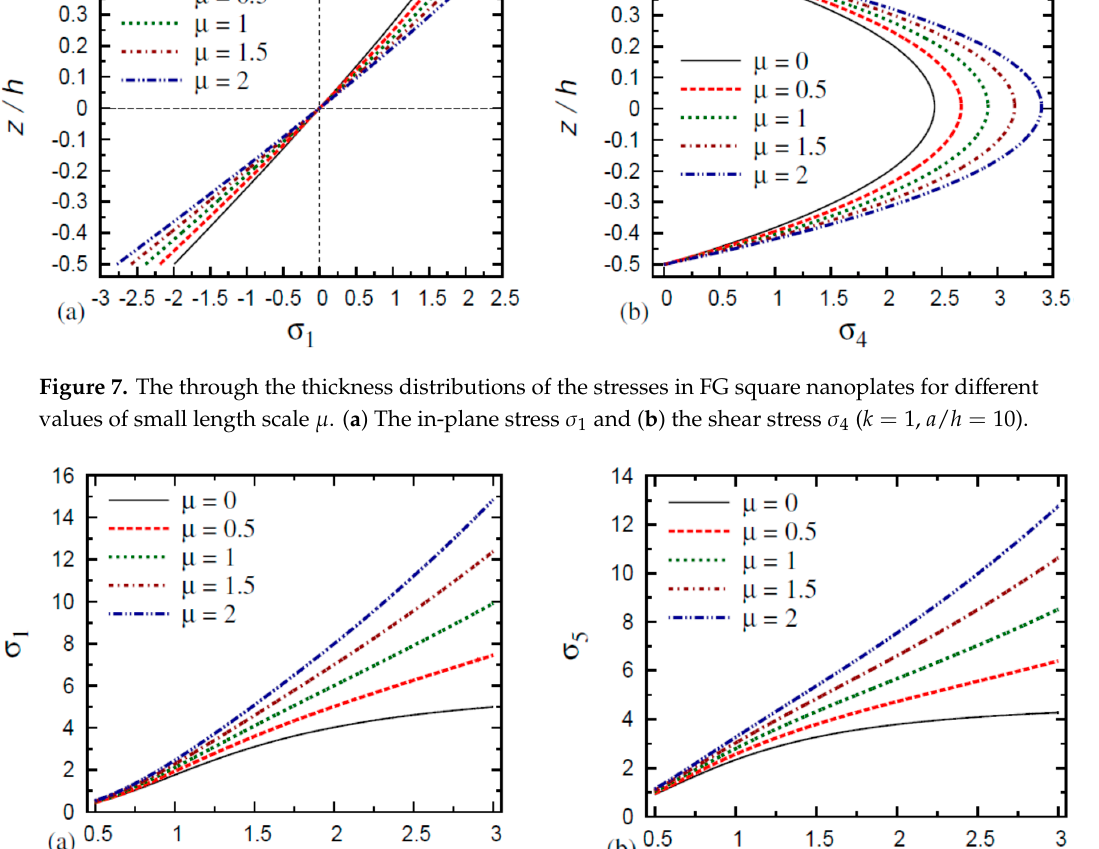
Figure 8. Variation in non-dimensional stresses in FG nanoplates versus the aspect ratio b / a for di ff erent values of small length scale µ . ( a ) The in-plane stress σ 1 and ( b ) the shear stress σ 5 ( k = 1, a / h = 10 ).